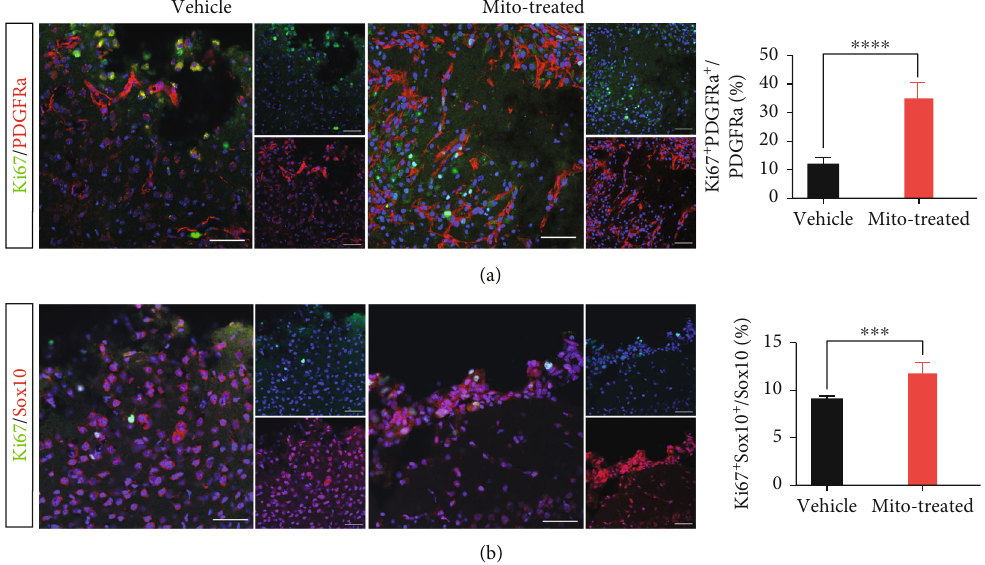
Figure 3: E ff ects of exogenous mitochondria on the proliferation of OPCs. (a) Double immunostaining of Ki67/PDGFR α at 5d posttransplantation. (b) Double immunostaining of Ki67/Sox10 at 5 d posttransplantation. Ki67/PDGFR α - and Ki67/Sox10-positive cells signi fi cantly increased in mitochondria-treated mice, as compared to control. Representative images were taken from lesion boarder. Student ’ s t test. N = 5 mice per group. ∗∗ P < 0 : 01 . ∗∗∗ P < 0 : 001 . ∗∗∗∗ P < 0 : 0001 . Bars = 50 μ m